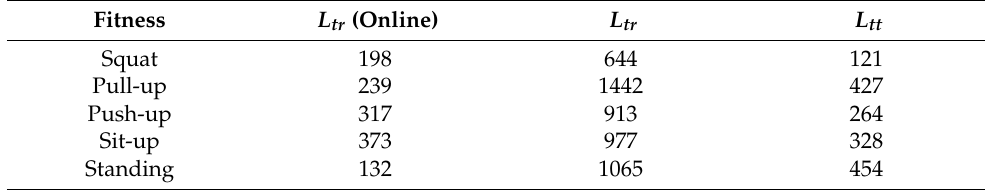
Table 5. Category and number of images.